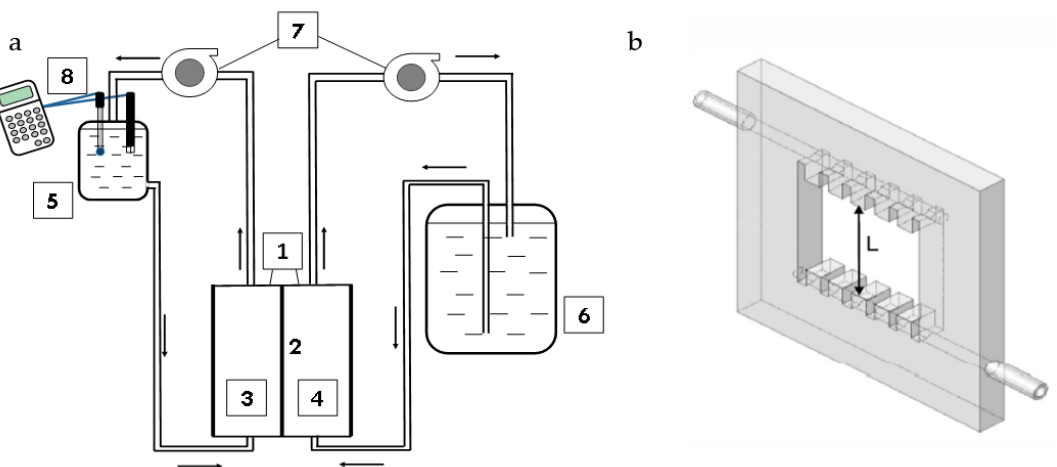
Figure 12. ( a ) Schematic representation of the experimental setup for measuring the membrane diffusion permeability: (1) two-compartment cell, (2) membrane under study confined between two frames shown in ( b ), (3, 4) flow-through compartments of cell (1), (5) container with initially distilled water, (6) container with the electrolyte solution of a given concentration, (7) pumps, and (8) conductometric and pH electrodes connected with conductometer and pH meter, respectively; ( b ) plastic frame with special comb-shaped guides of liquid flow.